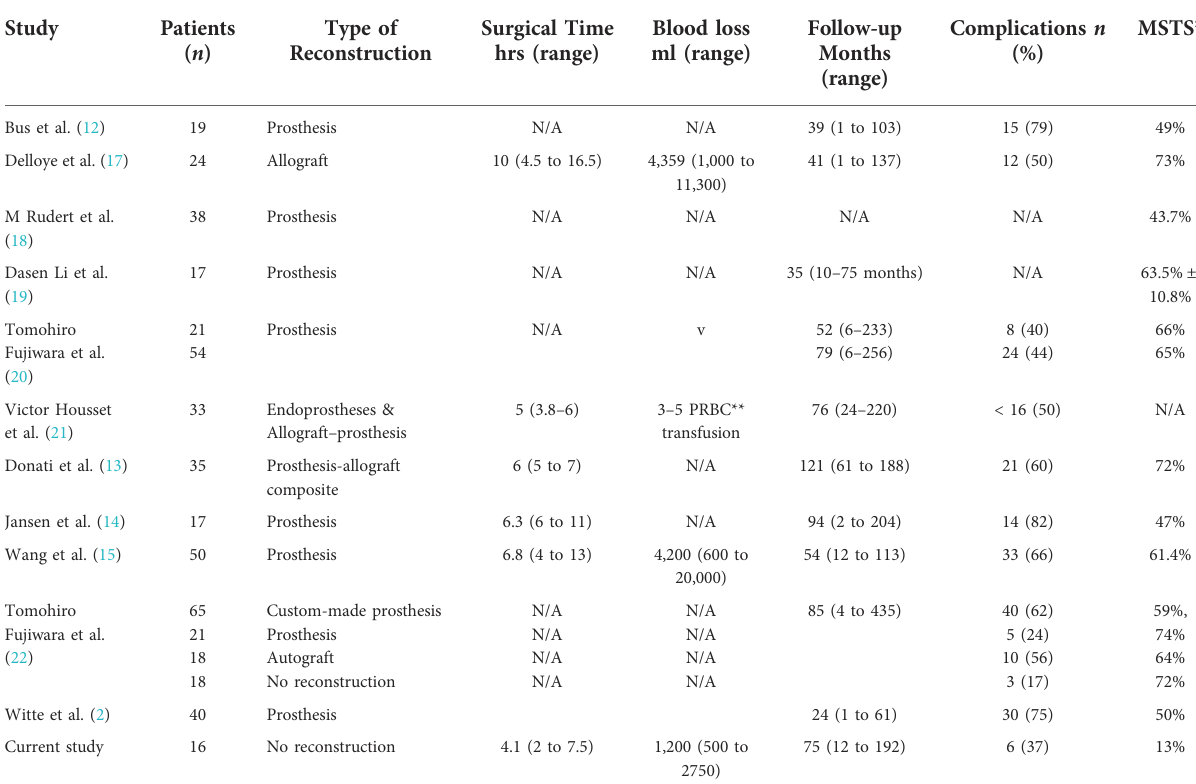
TABLE 4 Surgical details and